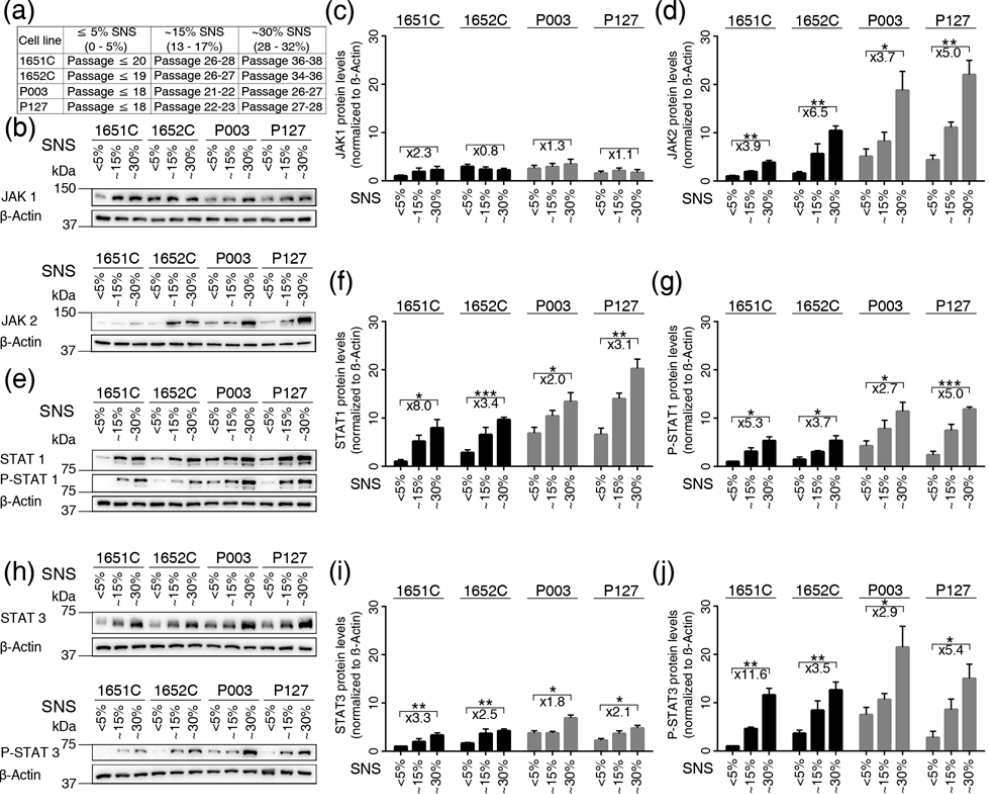
Figure 3. Status of the JAK-STAT signaling pathway in control and HGPS cells during replicative senescence. ( a ) Table showing the cell strains and the passages corresponding percentages of senescence (SNS). ( b , e , h ) Representative western blot images for JAK1 / 2, STAT1 / 3, p-STAT1 (tyr701), p-STAT3 (tyr705) and β -actin in the control (GMO1651c, and GMO1652c) and HGPS (HGADFN003, and HGADFN127) cell strains at the indicated percentages of senescence. ( c ) Quantification of JAK1, ( d ) JAK2, ( f ) STAT1, ( g ) p-STAT1, ( i ) STAT3, and ( j ) p-STAT3. Graphs show the mean ± SD. (* p < 0.05, ** p < 0.01, *** p < 0.001, n > 3). Fold changes between the samples with 5% and 30% senescence are indicated.